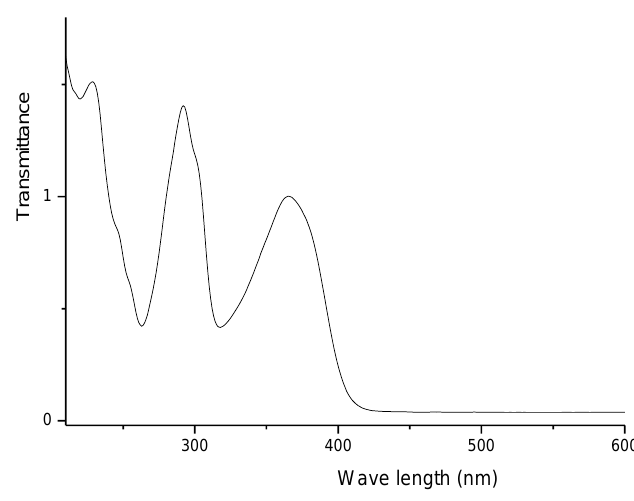
Fig. S4. UV-Vis spectrum of H